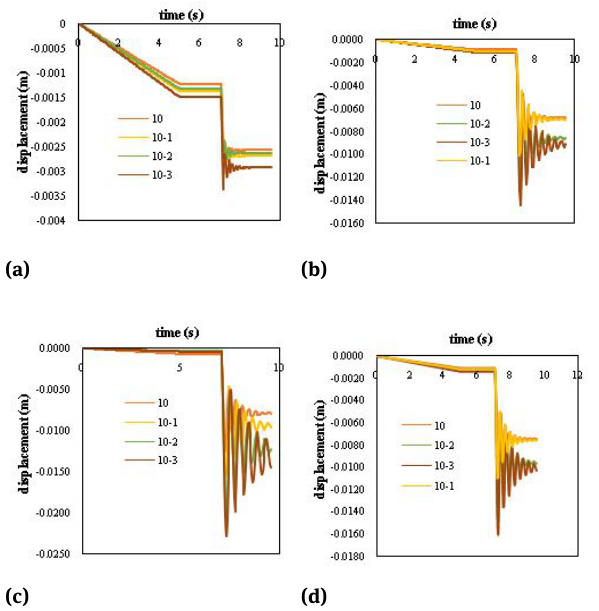
Figure 7: Nonlinear dynamic curves of 10-sory structures, (a) D1-6 th Floor; (b) D3-6 th Floor; (c) G3-6 th Floor; (d) D3-8 th